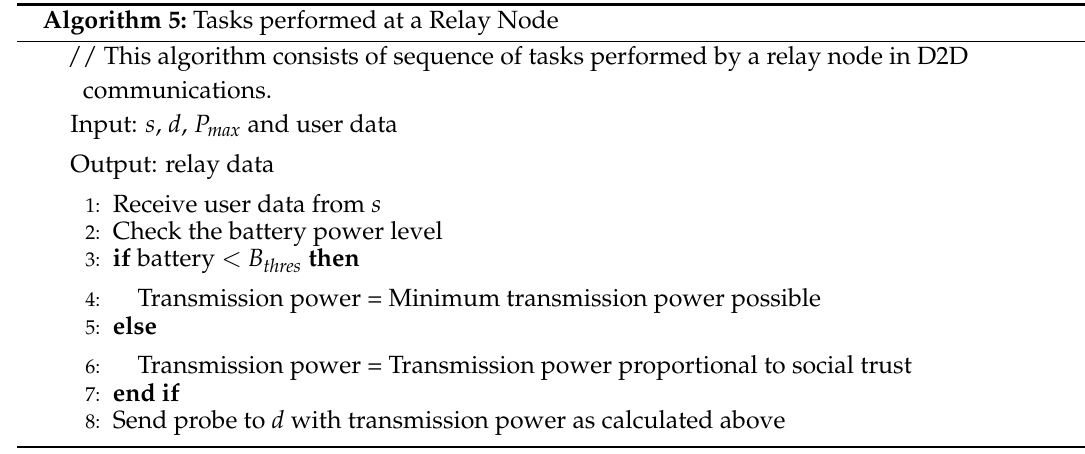
Algorithm 6: Tasks performed at